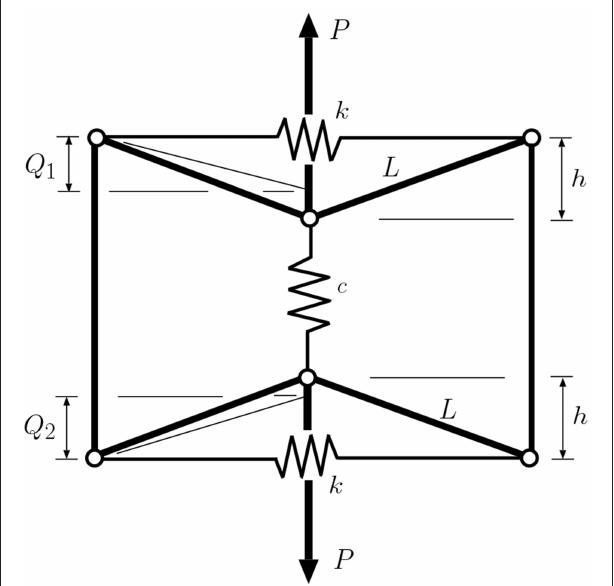
FIGURE 22 | A new model for an auxetic cell, depicted in the unloaded state Q 2 h . The illustrated auxetic configuration becomes where P 0 and Q 1 = = = non-auxetic once the arms have passed through horizontal. Typically, the arches snap through in turn rather than